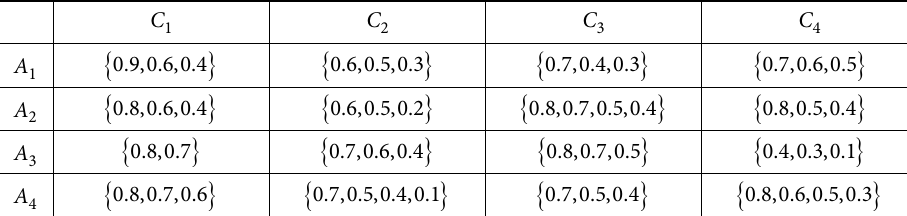
Table 3. Hesitant fuzzy decision matrix of expert e 3